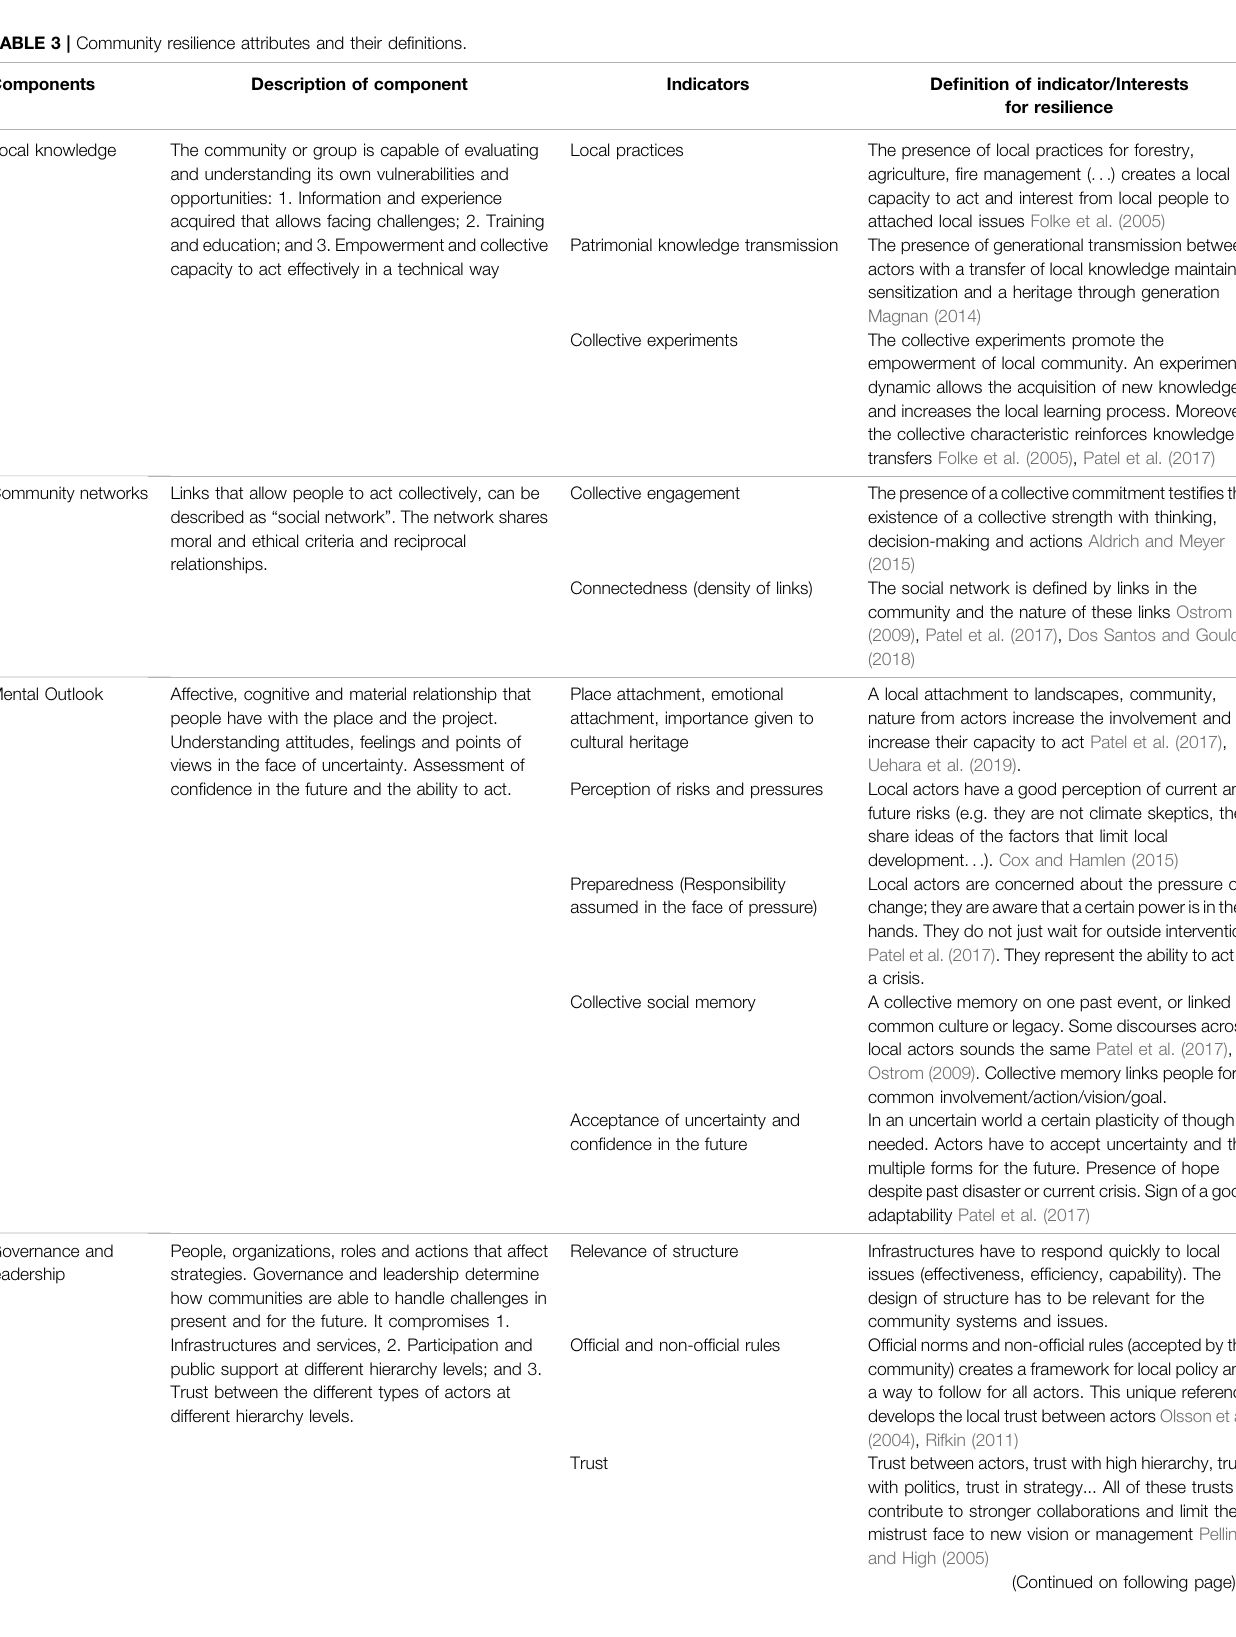
TABLE 3 | Community resilience attributes and their de fi